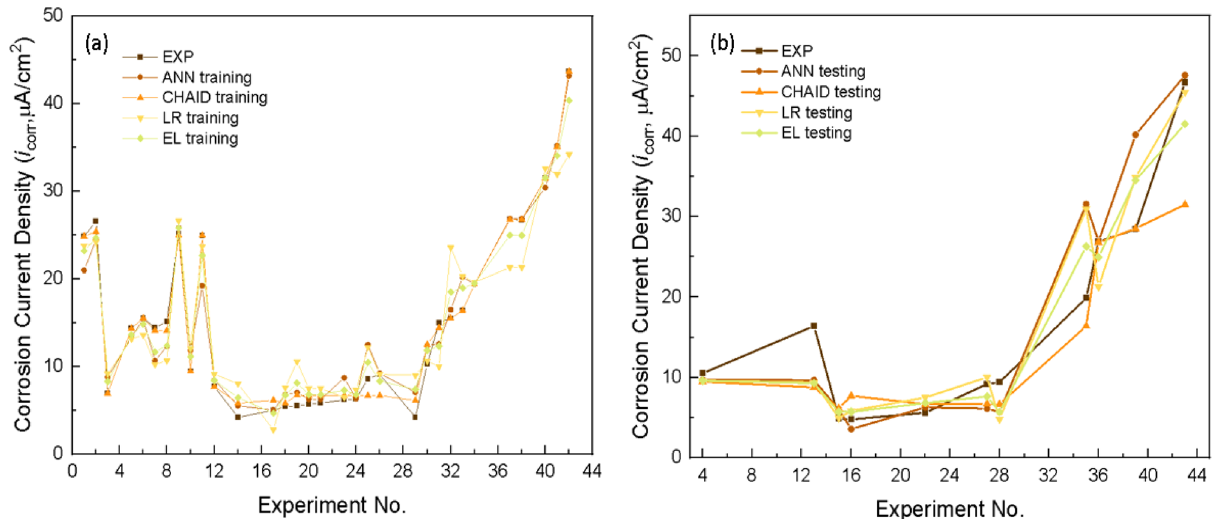
Figure 16. Predicted value versus the measured external corrosion rate ( a ) training data ( b ) testing data of carbon steel in